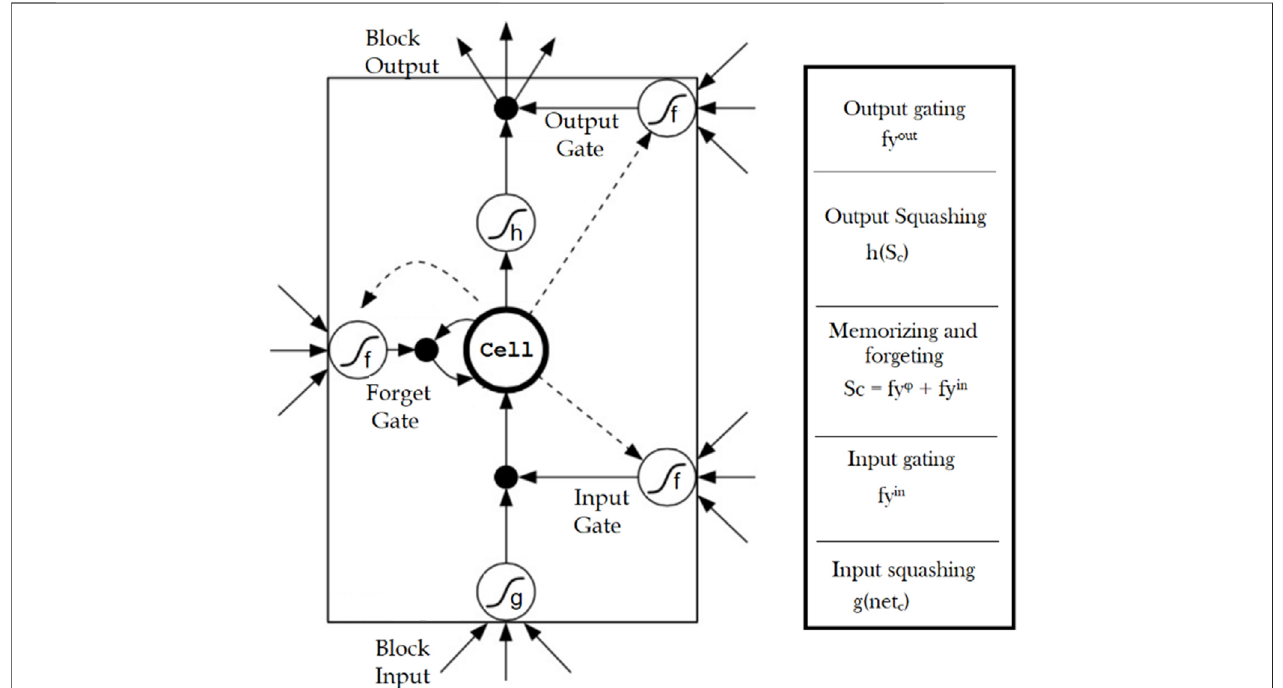
FIGURE 5 | Structure of LSTM